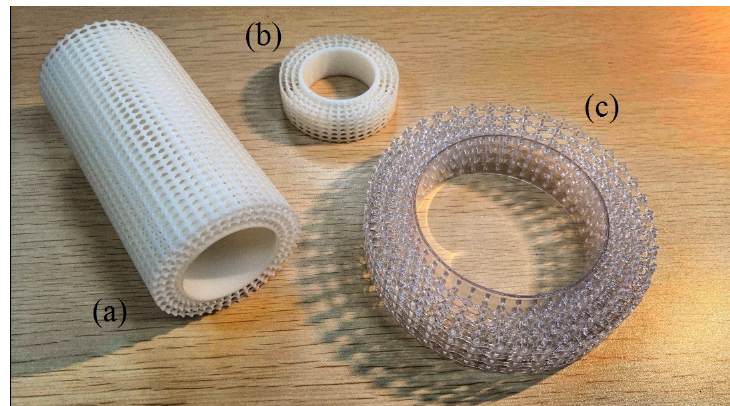
Figure 5. Some SPCC 3-D printed samples. Each of the cylinders use the same design as presented in this paper, yet are scaled in the radial direction to produce cylinders of different D but with t / d =